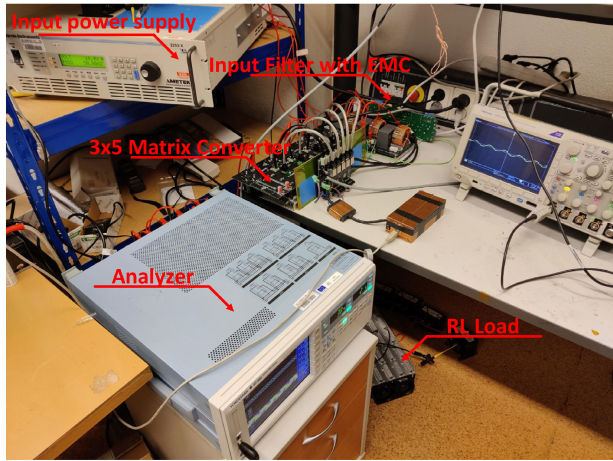
Figure 11. Test setup for the implemented control